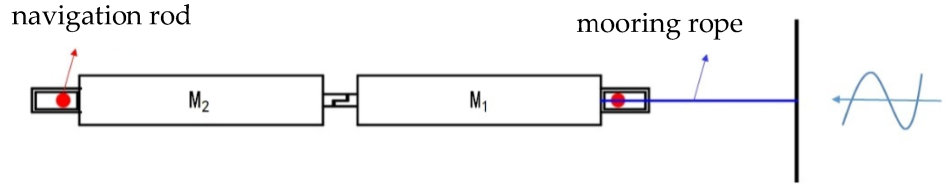
Figure 4. Mooring scheme under a head wave.